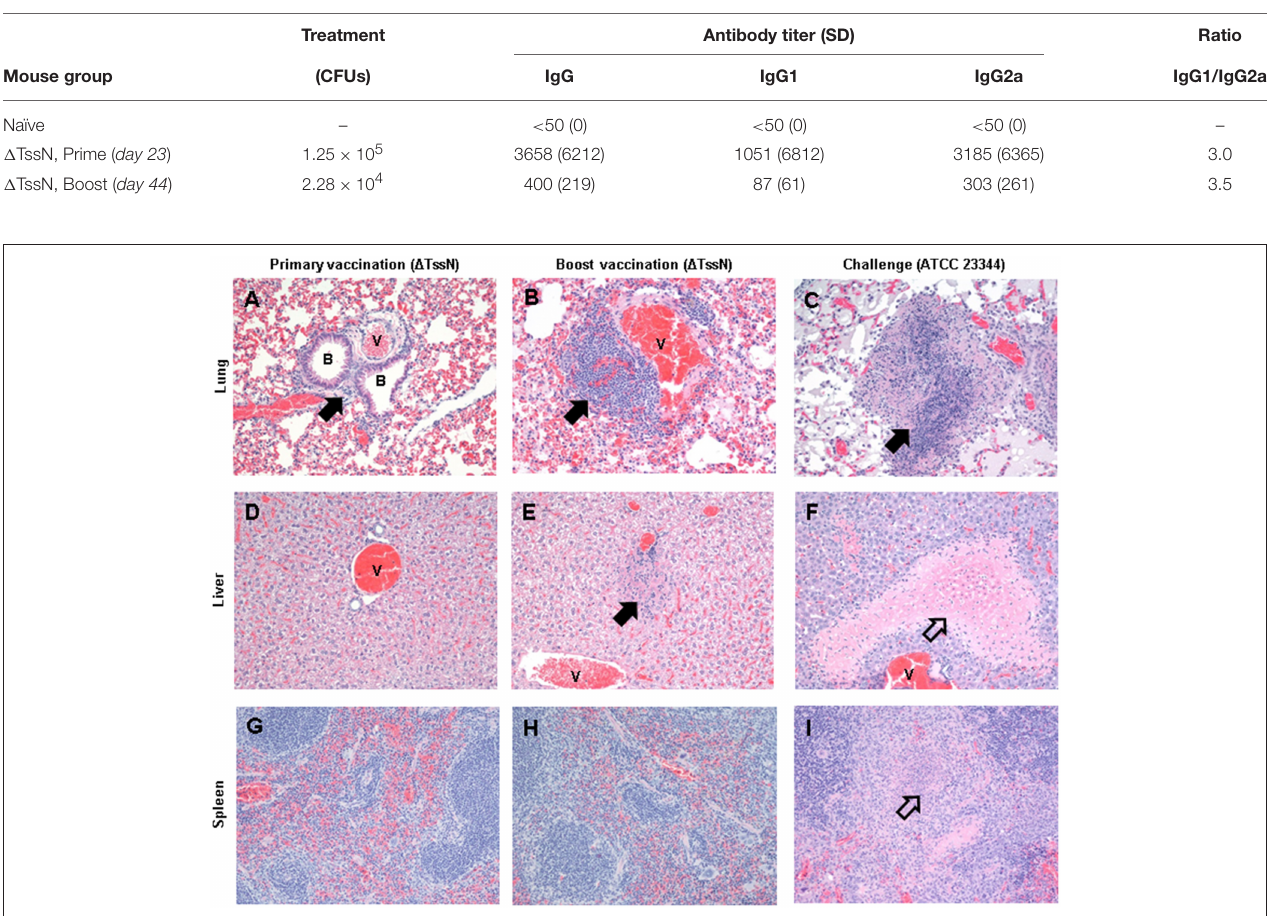
FIGURE 8 | Histopathology of vaccinated and challenged mice. Histopathology of the lung (A–C) , liver (D–F) , and spleen (G–I) for mice 21 days after primary and boost vaccinations with 1 TssN, and after challenge with ATCC 23344. Sites of inflammation (filled arrow) and necrosis (hollow arrow) are noted, as well as relevant bronchioles (B) and blood vessels (V). All images are at × 200